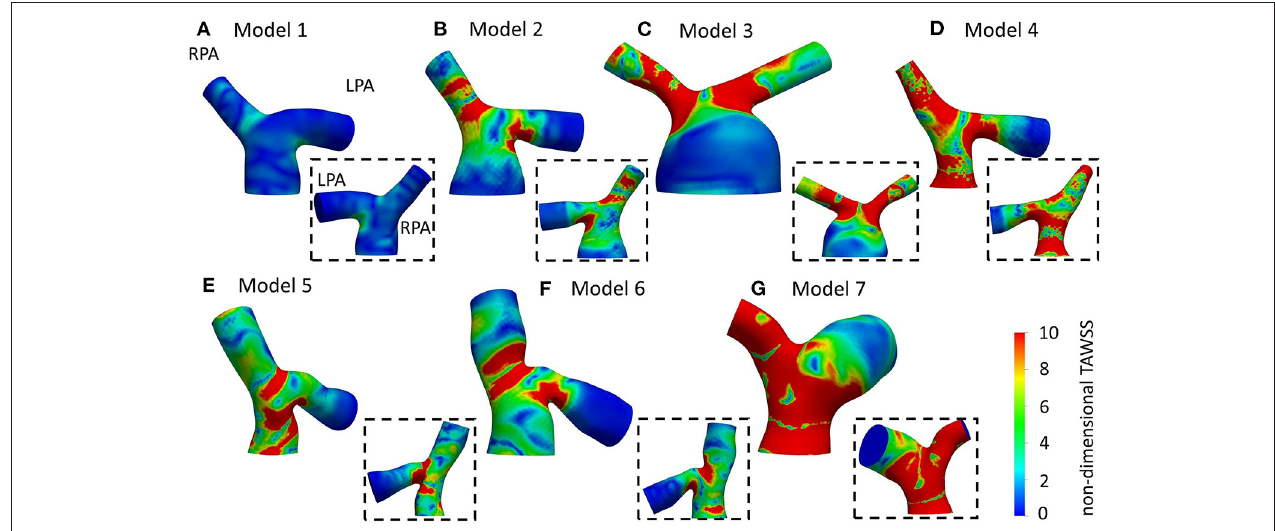
FIGURE 9 | Non-dimensionalized time-averaged wall shear stress (TAWSS n ) distribution, normalized by the wall shear stress value at the inlet of each model, respectively, for (A) Model 1; (B) Model 2; (C) Model 3; (D) Model 4; (E) Model 5; (F) Model 6; and (G) Model 7. Insets show the back view of the models. The LPA and RPA branches are indicated in Model 1.